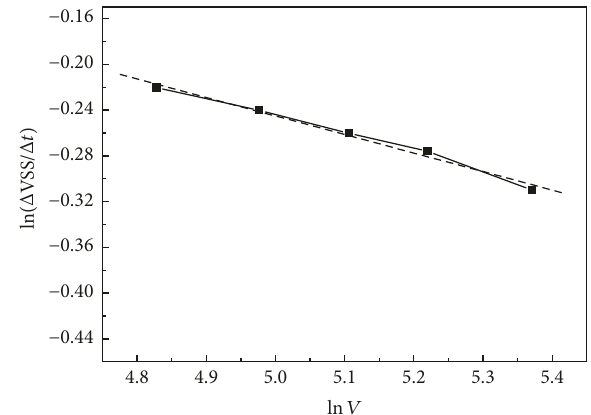
3.59 (g ⋅ L −1 ) −1.0587 ⋅ (ml ⋅ s −1 ) 0.0976 ⋅ (r ⋅ min −1 ) 0.1618 , respectively.